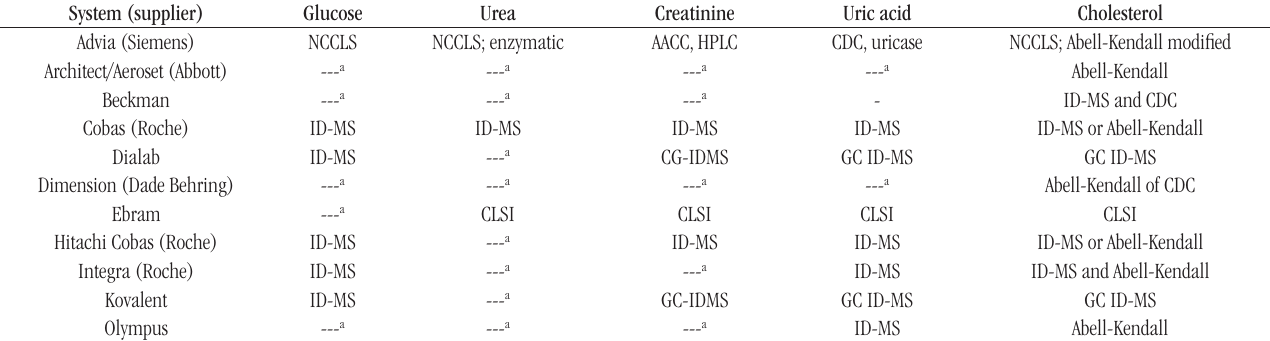
taBLE 5 − RMets used in the analytical systems of the investigated glucose, urea, creatinine, and